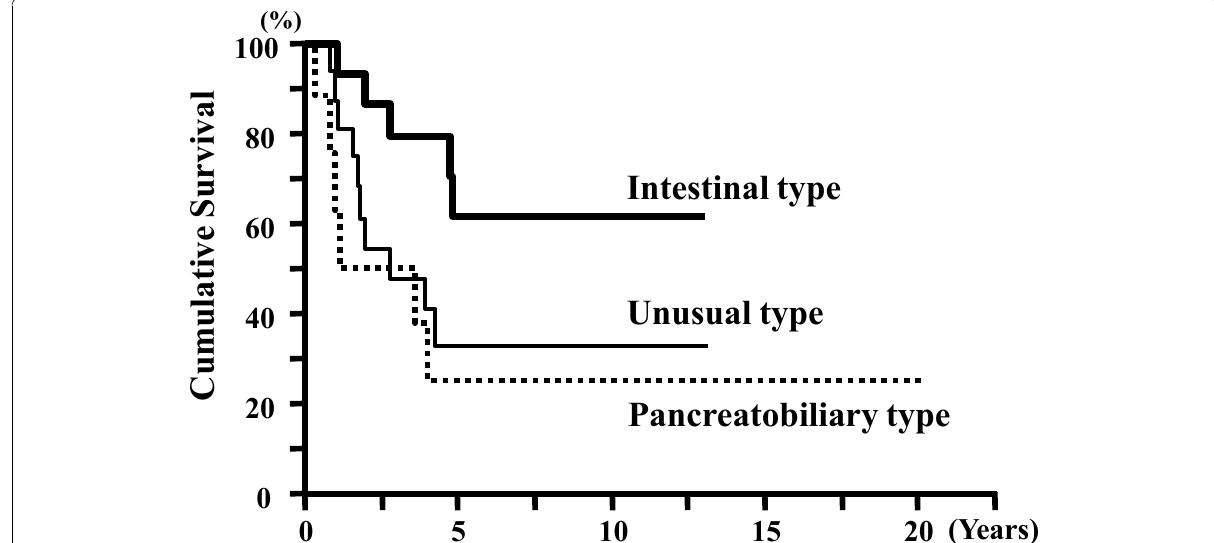
Figure 4 Cumulative survival of patients with ACs of different histological types: intestinal-type, pancreatobiliary-type, and unusual- type . Patients with intestinal-type tumors showed significantly better survival than those with the pancreatobiliary- and unusual-type tumors (p = 0.031).